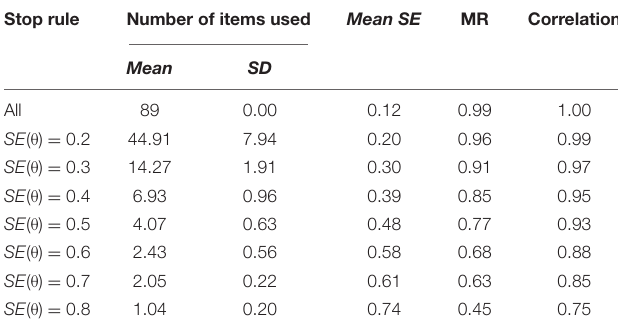
TABLE 4 | Simulation results under seven stop rule